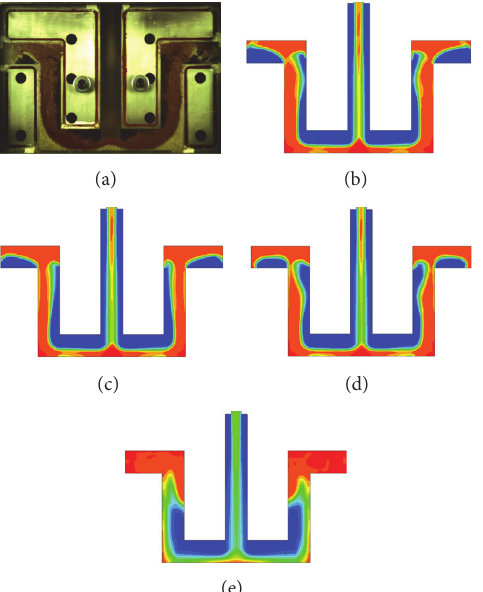
Figure 3: Comparison of (a) experimental result with predicted instantaneous sand volume fraction for (b) 𝑒 = 0.5 , (c) 𝑒 = 0.8 , (d) 𝑒 = 0.9 , and (e) 𝑒 = 0.99 ( 𝑡 = 160 ms).